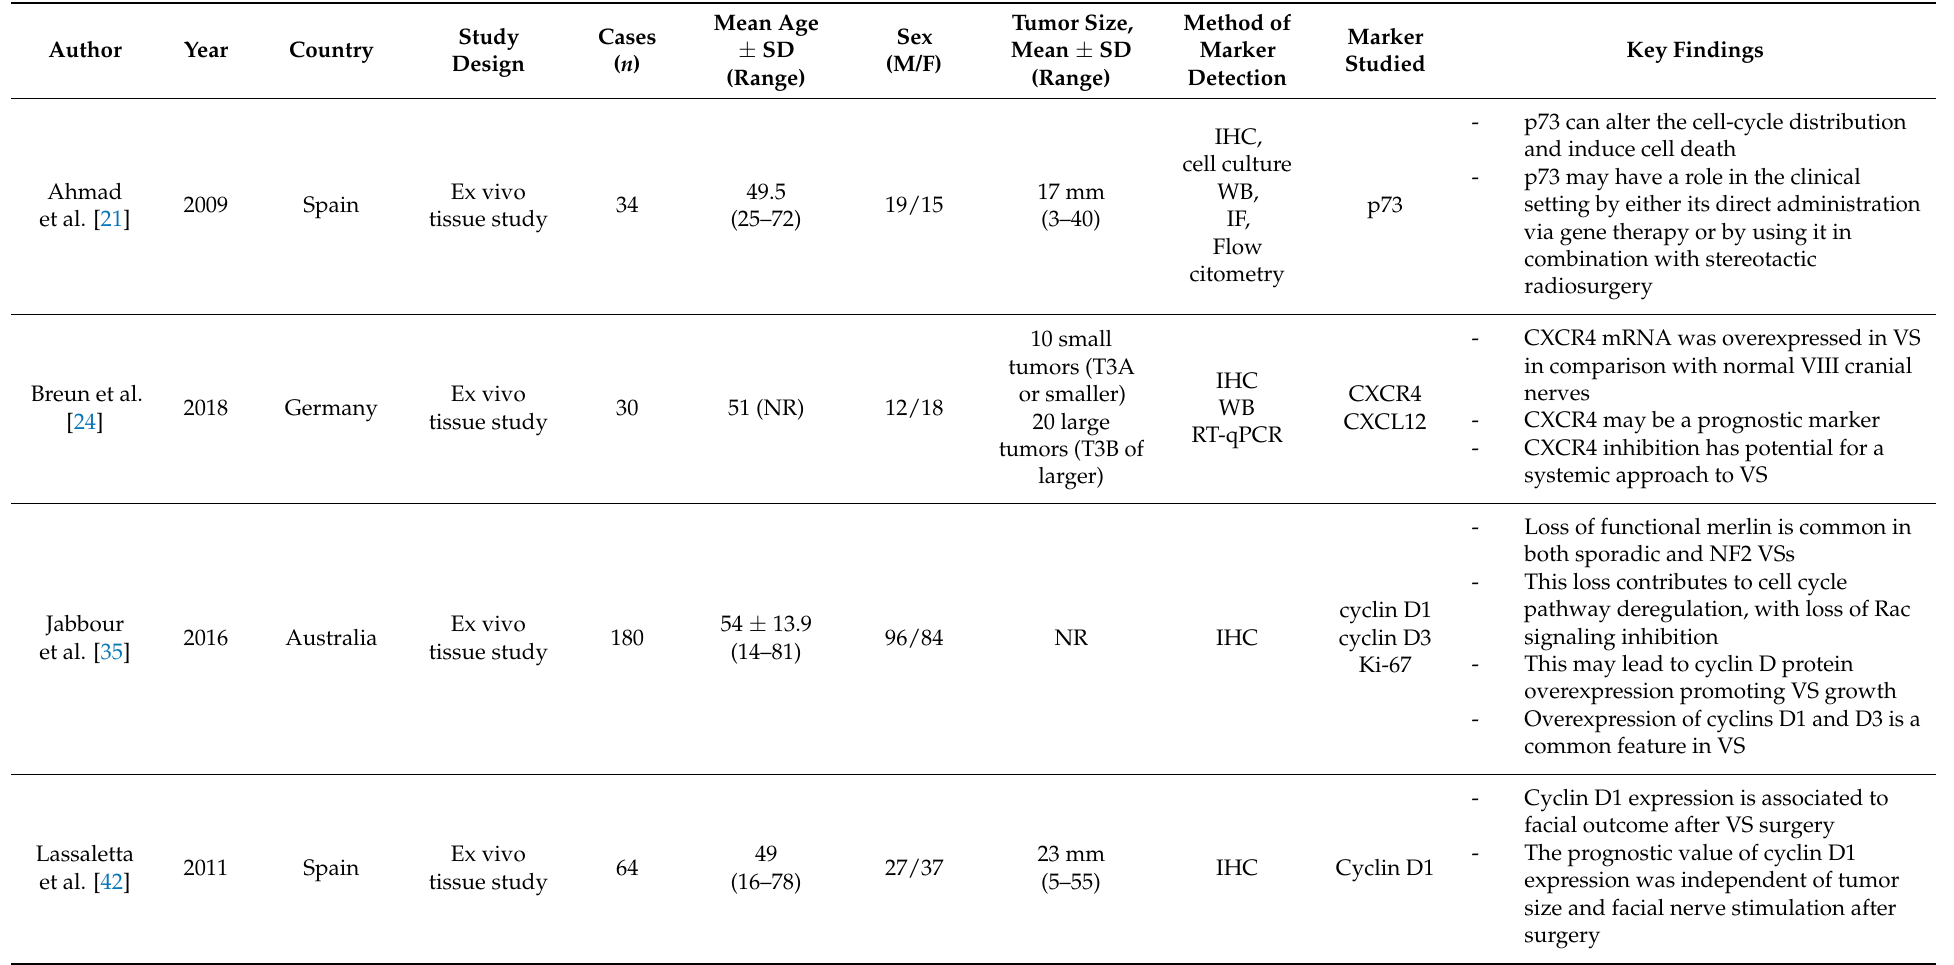
Table 3. Studies examining the role of molecular regulators in sporadic vestibular